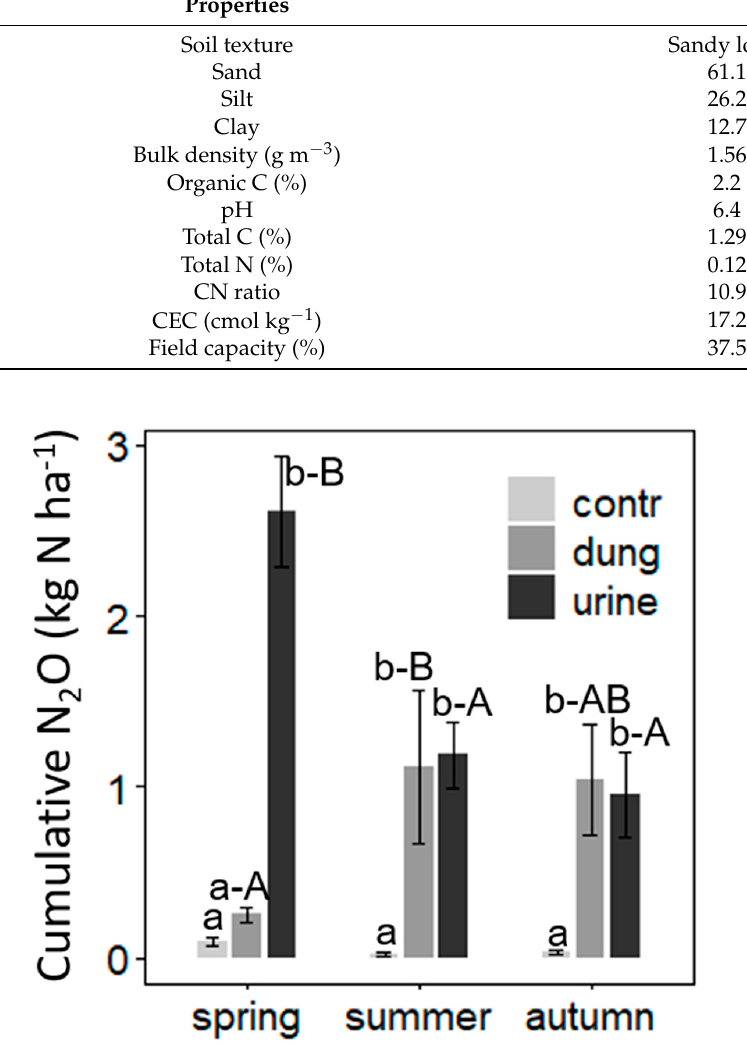
Figure A1. Graph showing the season x treatment interaction effect ( p < 0.01) on cumulative N 2 O emission irrigated binary-sward grasslands (Experiment 3). Means with different letters are significantly different ( p < 0.05; abc for the seasonal effect, ABC for the treatment effect). Table A3. Bivariate relationships between N 2 O-N emission factors and the measured/estimated variables.